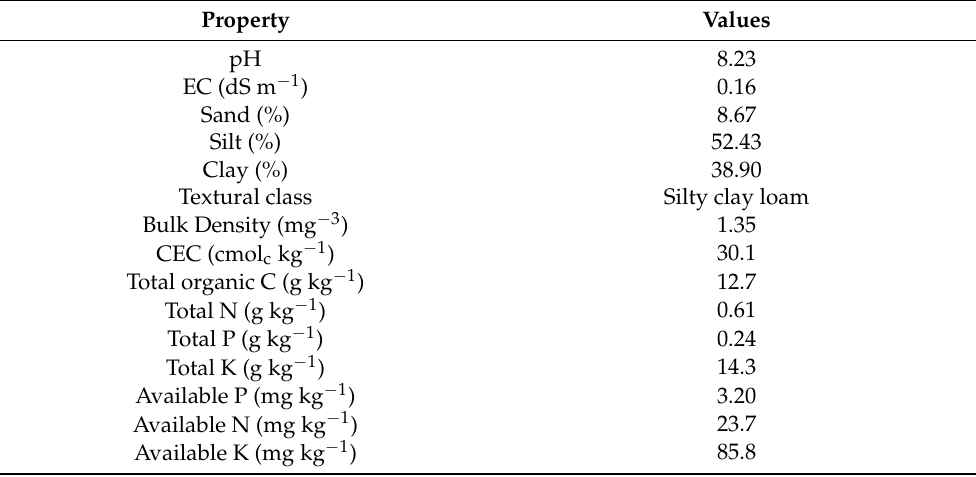
Table 1. Physicochemical properties of soil at the experimental